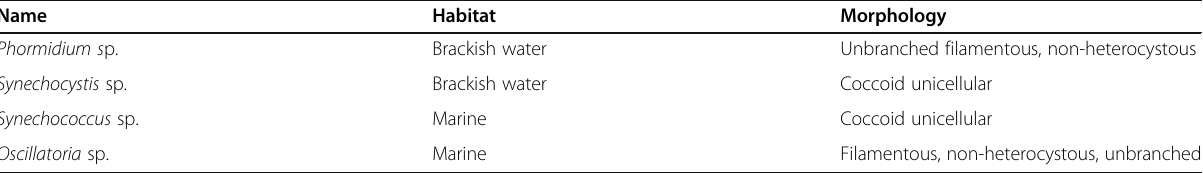
Table 1 The cyanobacterial isolates used in the antimicrobial screening as sources of aqueous extract